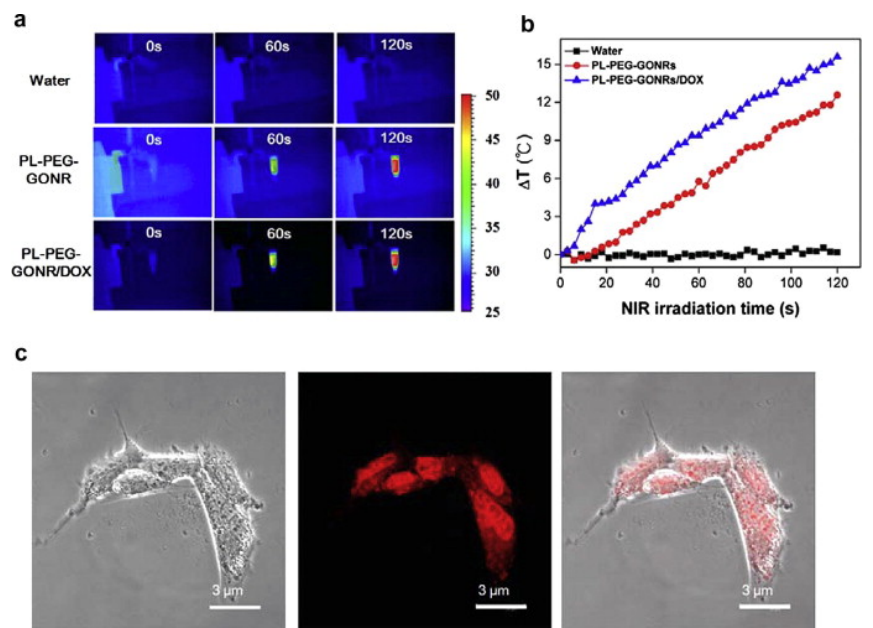
Figure 9. ( a ) NIR thermal images of water, PL–PEG–GONR, and DOX-loaded PL–PEG–GONR; ( b ) graph showing 120 s NIR irradiation with increasing temperature; ( c ) bright field ( left ), flu- orescence ( middle ) and merged micrographs ( right ) of U87 cells after treatment with PL–PEG– GONRs/DOX for 6 h observed by confocal laser scanning microscopy [232]. Copyright 2014, with permission from